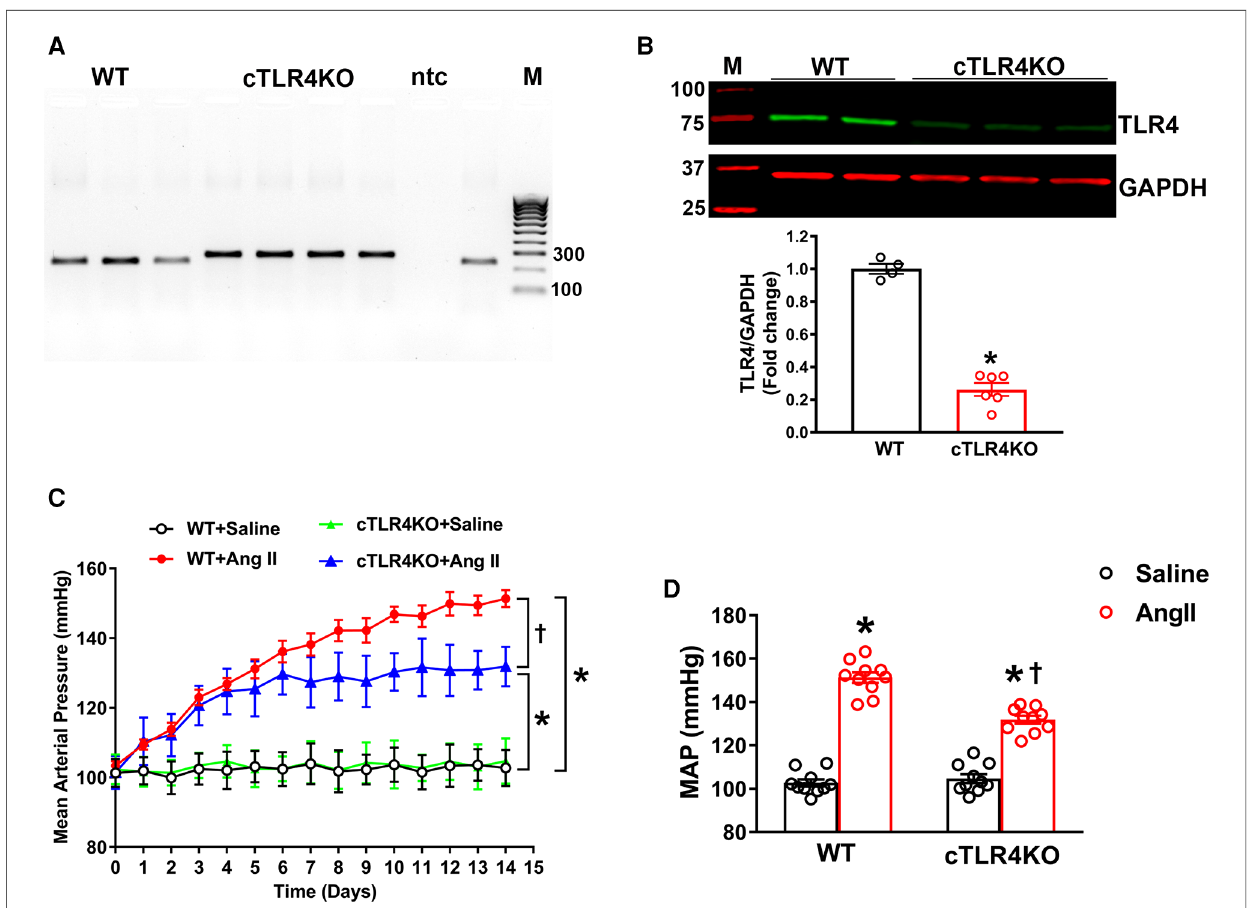
FIGURE 2 Cardiomyocyte-speci fi c TLR4 deletion attenuates angiotensin II-induced hypertension. ( A ) Mouse genotyping PCR using genomic DNA extracted from tail snips con fi rms that cardiomyocyte-speci fi c TLR4 deletion (cTLR4KO) mice contain only the cTLR4KO band (300 bp, samples 4 – 7), as wild-type